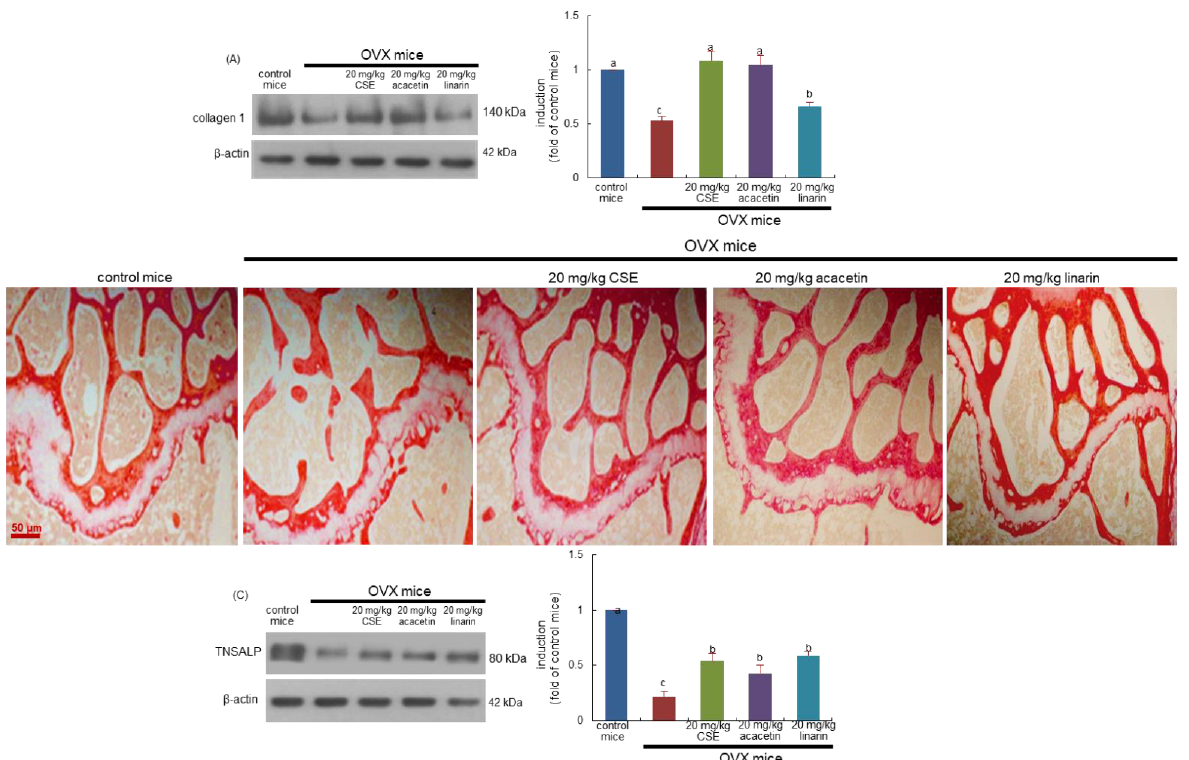
Figure 7. Boosting effects of Cirsium setidens water extracts (CSEs), acacetin, or linarin on induction of collagen type-1 ( A ), formation of trabecular collagen fibers ( B ), and tissue level of tissue non-specific alkaline phosphatase (TNSALP; C) in femoral bone of ovariectomized (OVX) mice. OVX mice were orally supplemented with 20 mg/kg CSEs, 20 mg/kg acacetin, or 20 mg/kg linarin daily for 8 weeks. Whole bone tissue extracts were subjected to SDS-PAGE and Western blot analyses with specific antibodies against collagen type 1 and TNSALP ( A , C ). β -Actin was used as internal control. The bar graphs (mean ± SEM) in the right panels represent quantitative results obtained using a densitometer. Values in bar graphs not sharing a small alphabetical letter are different at p < 0.05. Picrosirius red staining was conducted for detecting trabecular bone collagen ( B ). The black arrows indicate the depletion of collagen fibers in trabecular bones of the epiphysis. Representative images were visualized using light microscopy. Scale bar = 50 μ m.